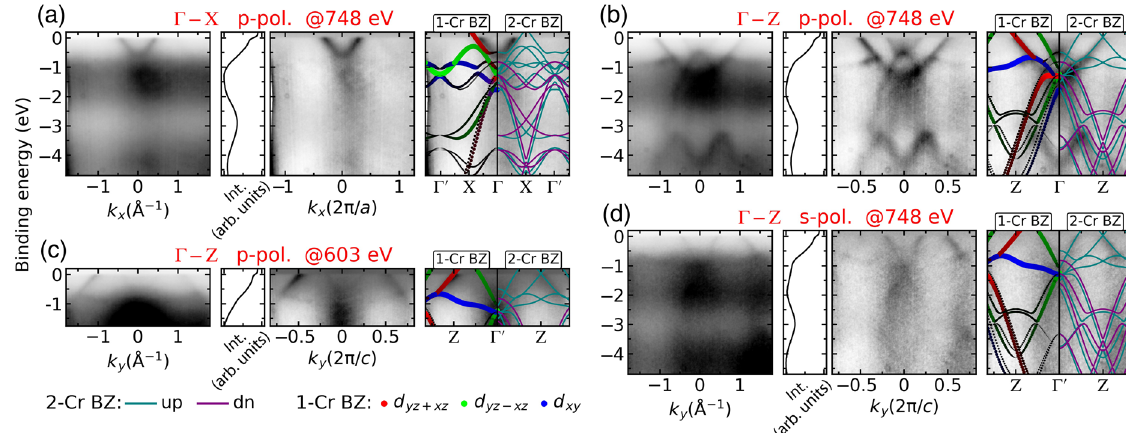
FIG. 2. Experimental and theoretical band dispersions in CrO 2 along the Γ - X and Γ - Z directions. The photon energy and x-ray polarization are indicated on top of each row (a) — (d) of the panels representing, from left to right, the raw ARPES image, a nondispersive spectral component coming mostly from the Cr 2 O 3 overlayer, a dispersive spectral component of CrO 2 , and the same data ¼ 0 . 4 eV) dispersions (majority spins in cyan and minority in magenta) and on > 0 side overlaid with the GGA þ U ( U on the k x;y eff < 0 side, with the corresponding bands unfolded onto the 1-Cr BZ. The unfolding nicely reproduces the experimental intensity the k x;y variation through the successive BZ and under x-ray